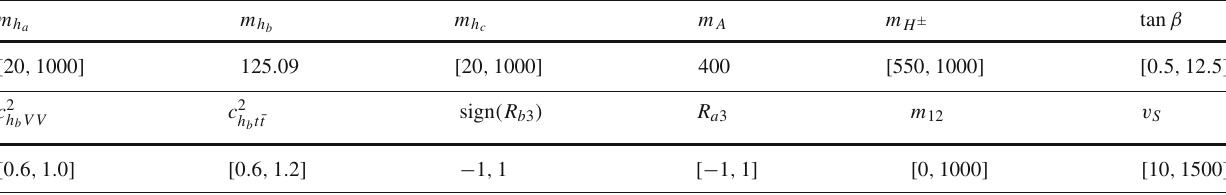
Table 1 Values of input parameters for the scan in type II for the investigation of the excesses at 400GeV. The states h a , b , c are automatically arranged according to the mass-ordered notation h 1 , 2 , 3 for each point by ScannerS m h